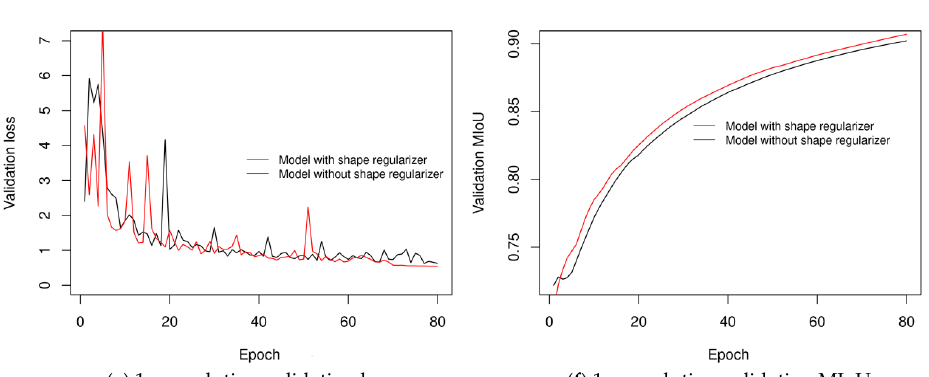
Figure 7. Learning curves of loss and MIoU of the models with and without the shape regularizer at different scales. ( a ) 4m resolution validation loss , ( b ) 4m resolution validation MIoU , ( c ) 2m resolution di ff erent scales. ( a ) 4 m resolution validation loss, ( b ) 4 m resolution validation MIoU, ( c ) 2 m resolution validation loss , ( d ) 2m resolution validation MIoU , ( e ) 1m resolution validation loss , ( f ) 1m resolution validation validation loss, ( d ) 2 m resolution validation MIoU, ( e ) 1 m resolution validation loss, ( f ) 1 m resolution MIoU . validation